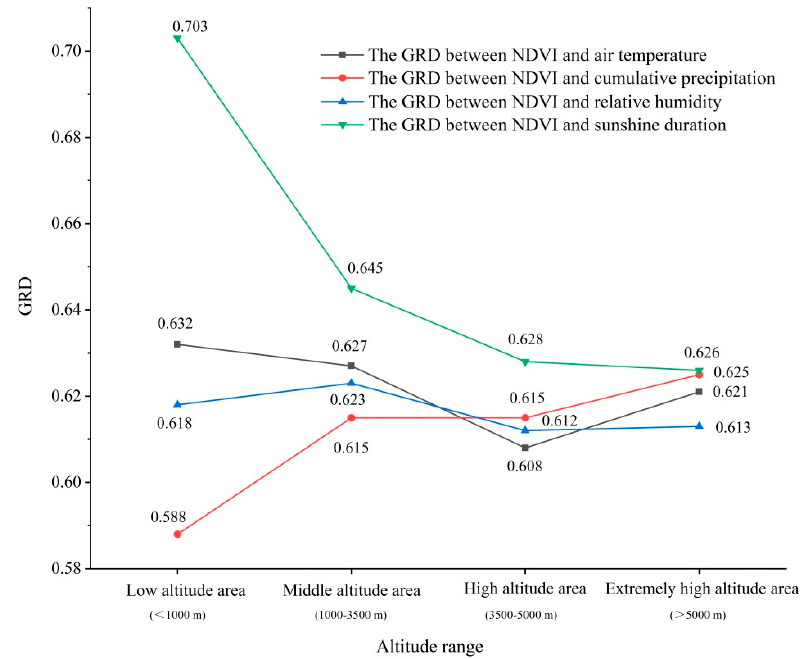
Figure 9. Variation of GRD between NDVI and air temperature, precipitation, relative humidity and sunshine duration at different elevations.